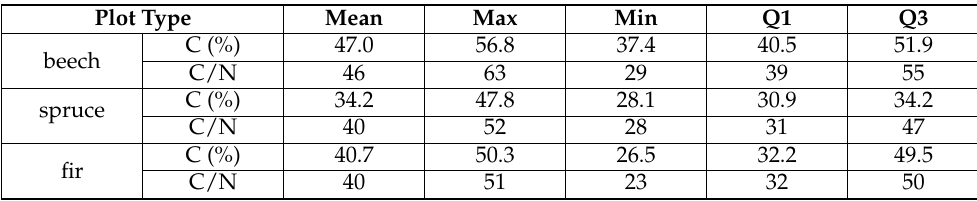
Figure 3. Distribution of fine roots biomass stock at the studied soil depths for the analyzed tree stands, expressed using boxplots. The box range denotes the interquartile range, line within the box—the median; whiskers indicate the minimum and maximum within range of three times interquartile ranges. Points indicate outliers. The different letters above the bars indicate statistically significant differences. Table 8. C content (%) and C/N ratio range of FR at each plot